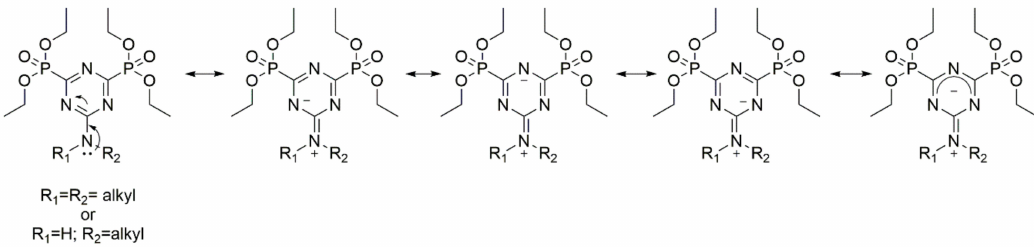
Scheme 3. Representative scheme showing the electronic resonance in a triazine ring because of the electron-donating ability of the amine